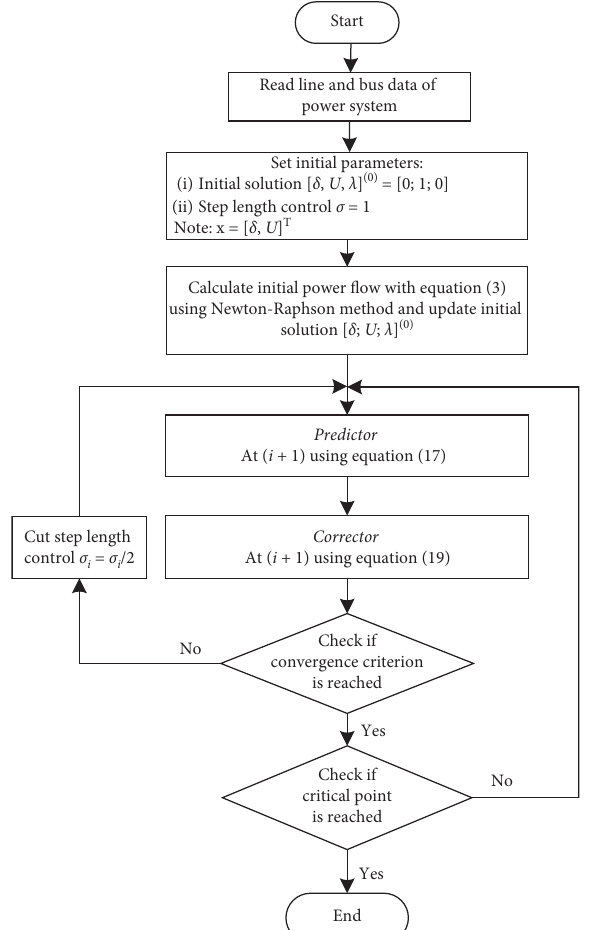
Figure 3: The flowchart of voltage stability analyses of the proposed